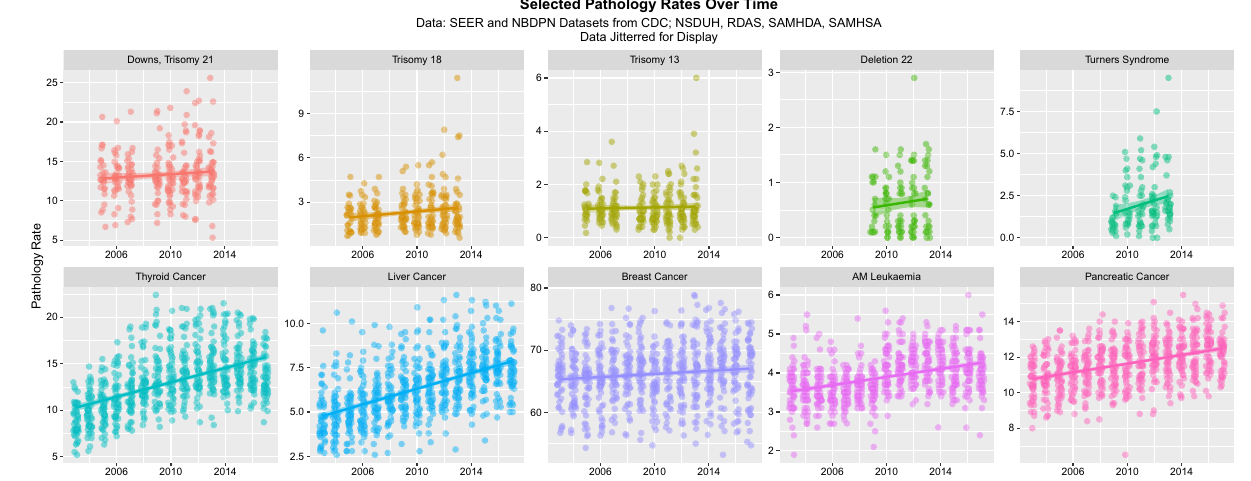
Figure 1. Raw congenital anomaly and cancer incidence data over time, by pathology type. (Created in R-Studio version 1.3.1093 using ggplot version 3.3.2).